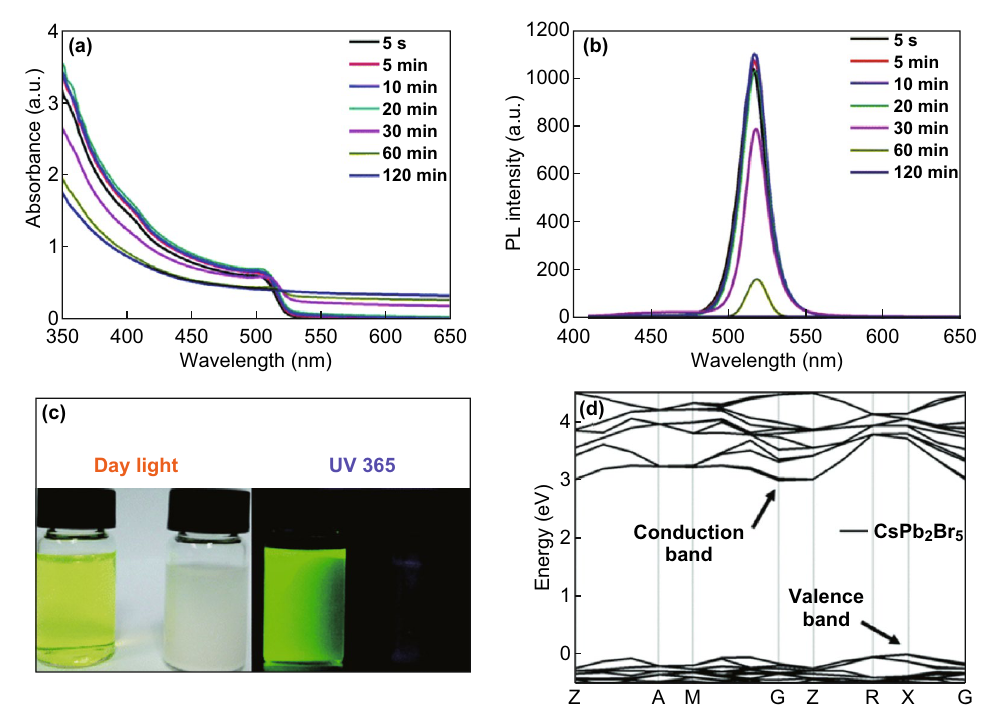
Fig. 4 Synthesis of non-emissive CsPb 2 Br 5 nanosheets from CsPbBr 3 nanocubes. a , b Disappearance of absorbance and PL as the reaction time increases. c CsPbBr 3 nanocube solution (after 5 s reaction time) and CsPb 2 Br 5 nanosheet suspension (after 2 h reaction time) in toluene under daylight (left) and a UV lamp (365 nm, right). d Calculated electronic band structure of CsPb 2 Br 5 . Reprinted with permission from Ref.